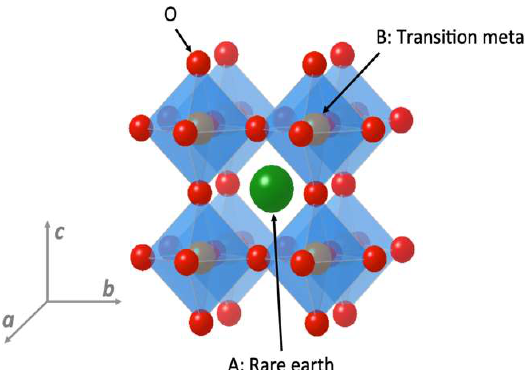
Figure 2. Schematic crystal structure of ABO 3 perovskite oxides, where A and B are a rare earth and transition metal atom.